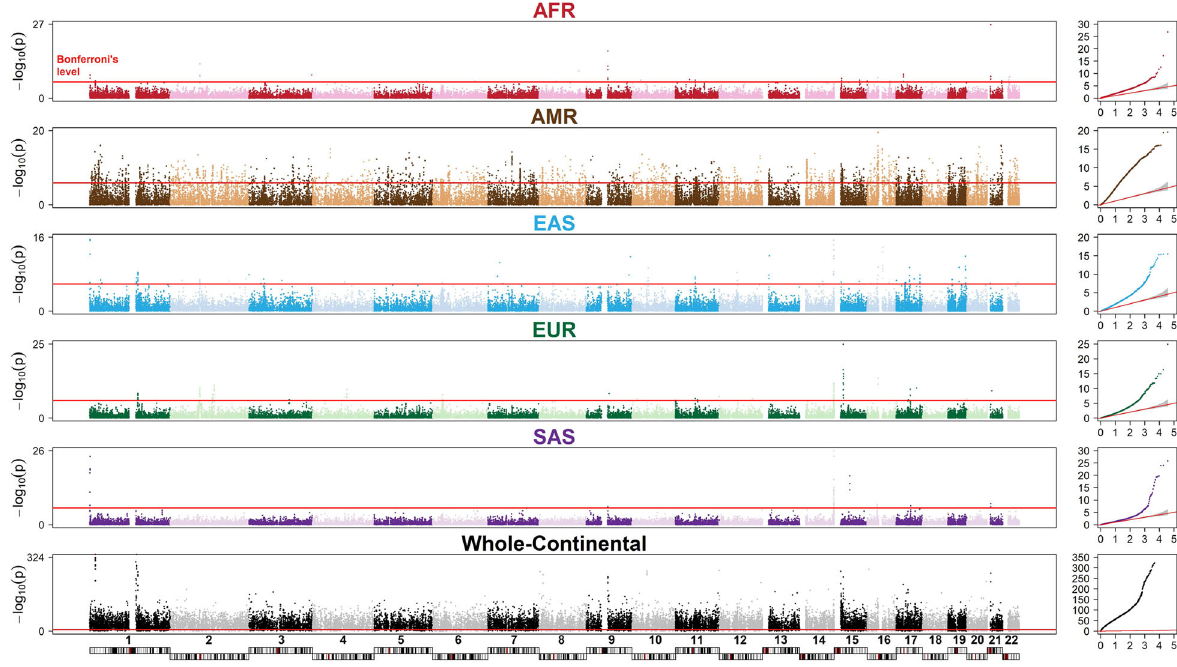
Fig. 8 Genome-wide homozygosity association study. The results of genome-wide homozygosity association tests for each of the fi ve studied continental ancestry groups (AFR, AMR, EAS, EUR, and SAS) and for a comparison of the fi ve continental ancestry groups in the whole-continental group (whole- continents) are shown in Manhattan plots. The vertical axis represents the P values ( – log10 scale) of the homozygosity association tests based on a two- sided Kruskal – Wallis test. The horizontal axis represents the physical positions of the anchor SNPs of sliding windows by chromosome. A red reference line indicates a P value threshold of a Bonferroni multiple-testing correction. Quantile – quantile plots (Q – Q plot) are provided on the right-hand side. Sample size n = 2504